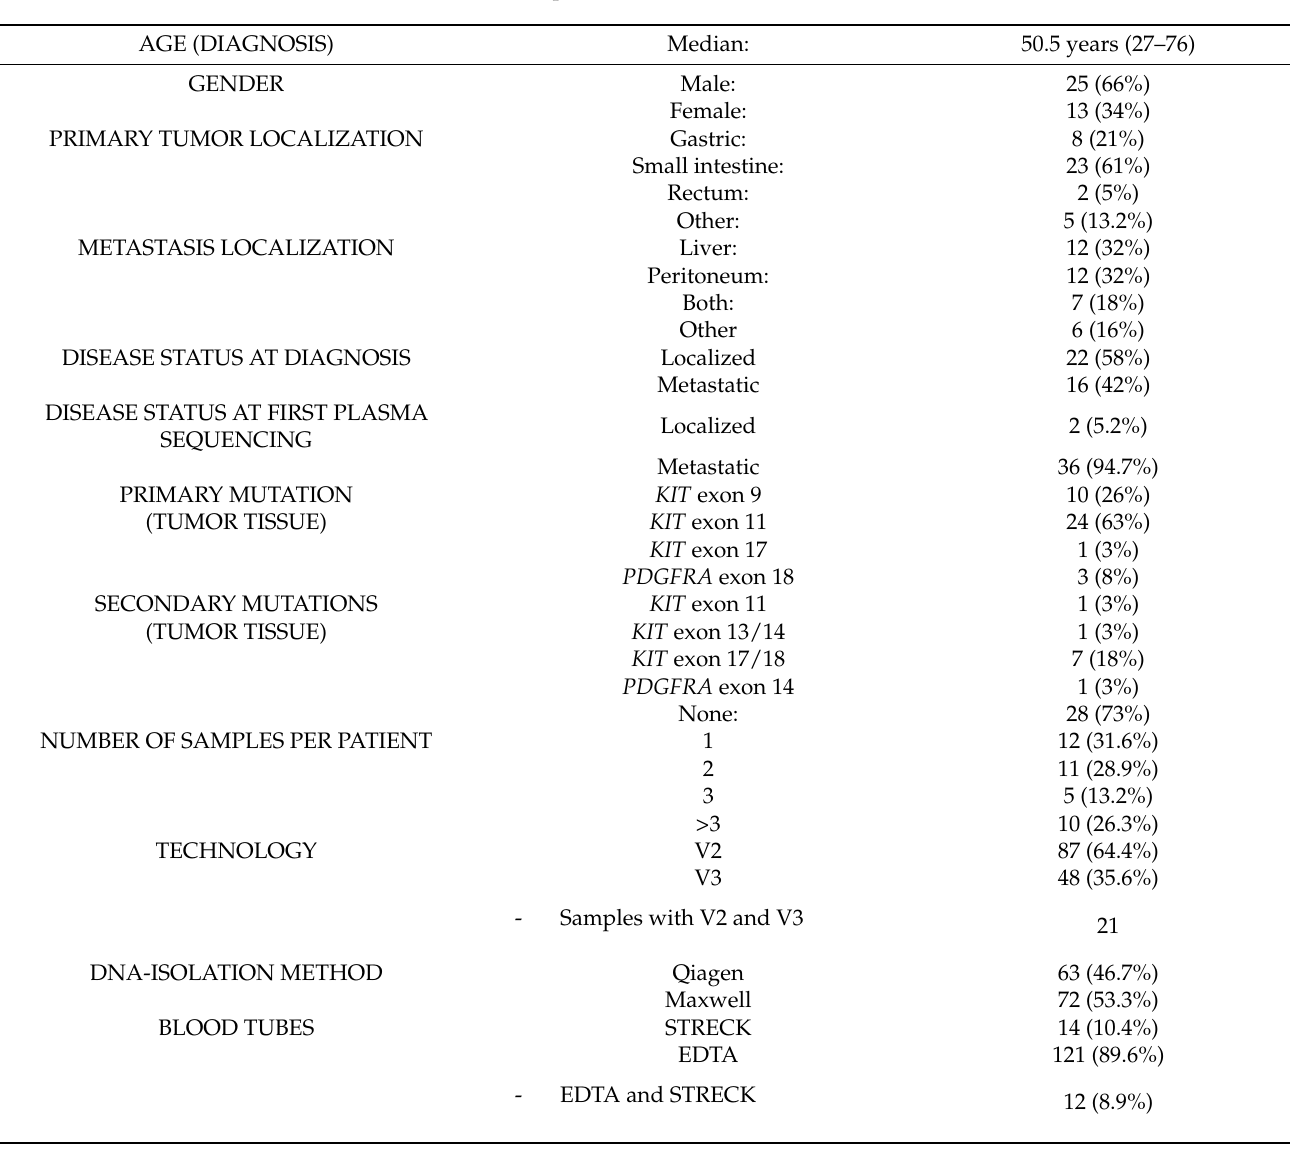
Table 2. Patient and sample